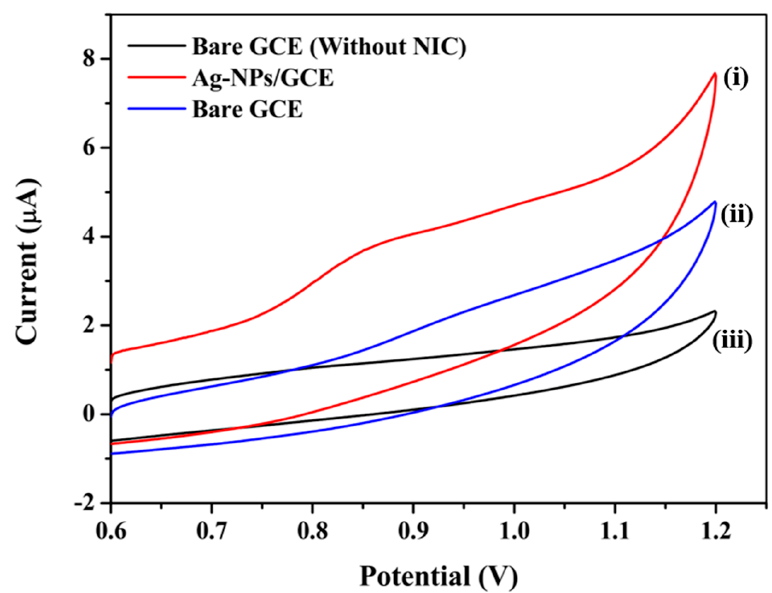
Figure 8. Cyclic voltammograms of Ag − NPs/GCE (i) and bare GCE (ii) were recorded in 0.1 M PBS containing 100 μ M of NIC at a scan rate of 50 mV/s. CVs of bare GCE in the solution without NIC (iii).